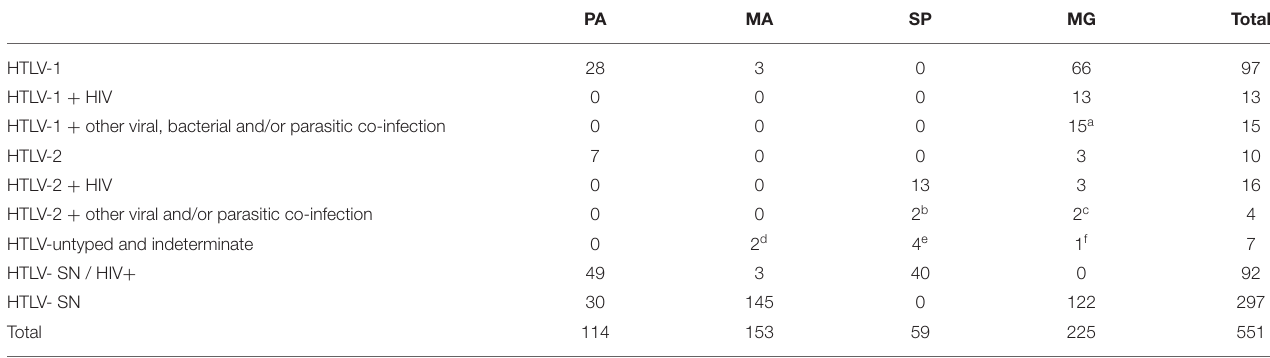
TABLE 1 | Characteristics of the HTLV-seropositive and seronegative (SN) sera samples. PA MA SP MG Total HTLV-1